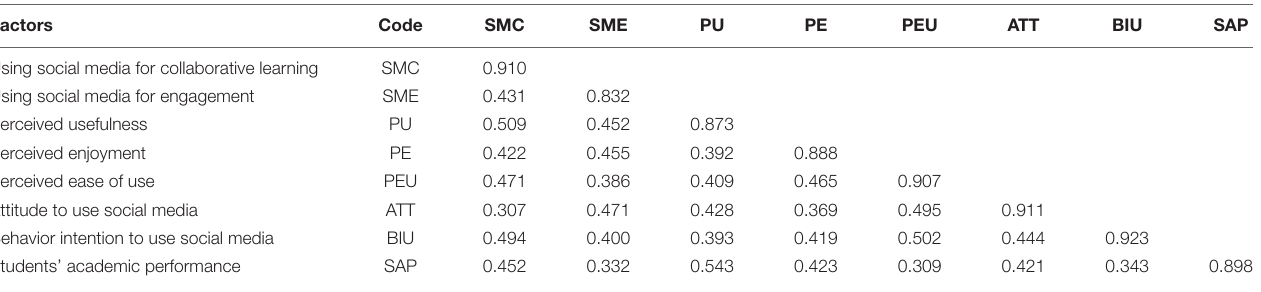
TABLE 2 | Sample covariances (Group number